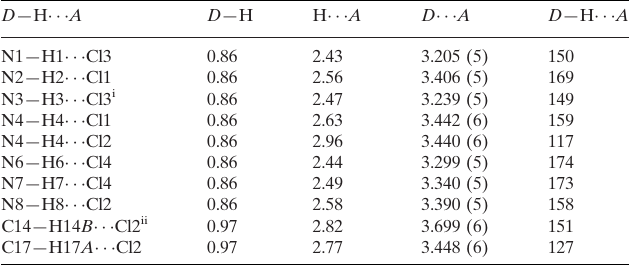
Hydrogen-bond geometry (A˚ , (cid:3)